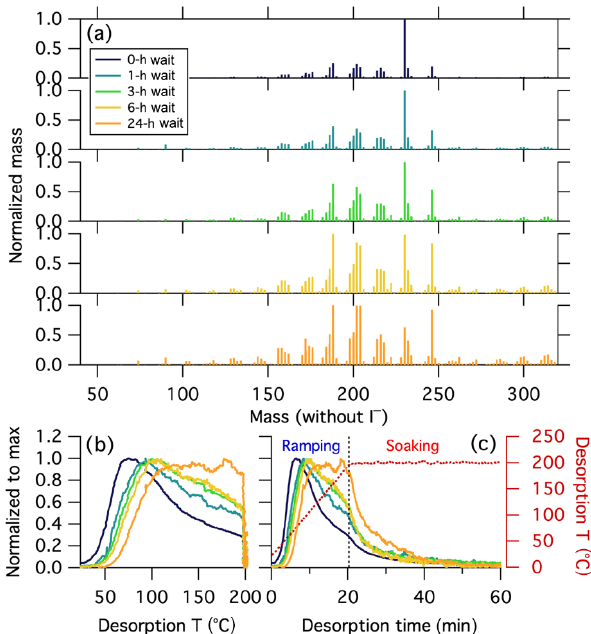
Figure 11. (a) Normalized mass spectra of α -pinene + O 3 SOA measured after different extents of isothermal evaporation at room temperature. The mass excludes iodine. The normalized thermo- grams of bulk SOA versus (b) temperature and (c) time, with the desorption temperature shown as a red dashed line. The vertical black dashed line in (c) delineates between ramping and soaking. The mass spectrum or thermogram colors indicate the isothermal evaporation time (see legend), with darker colors indicating shorter